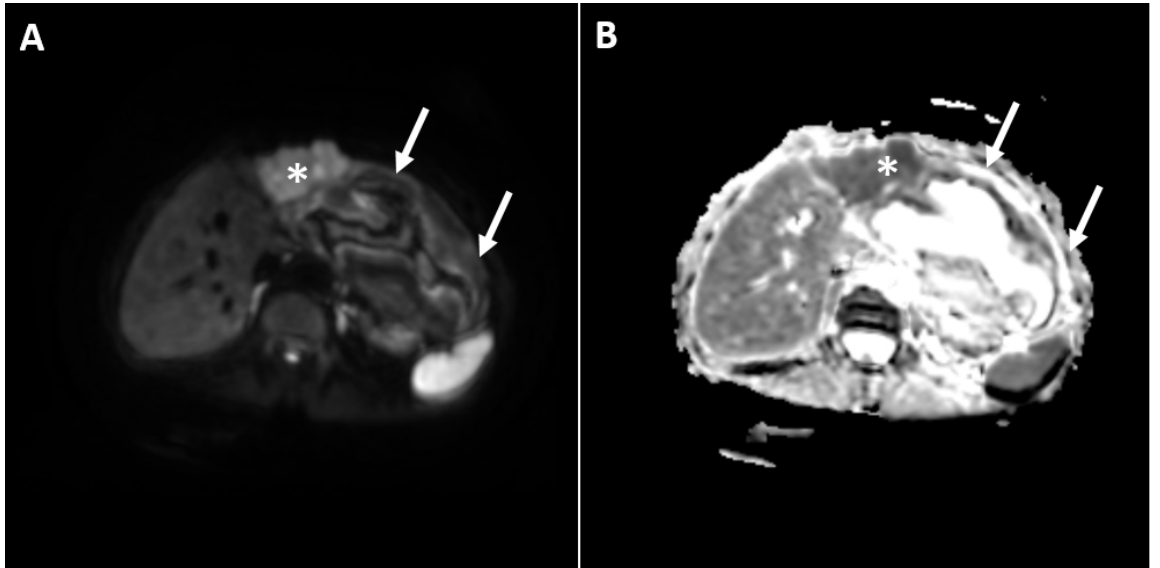
Figure 3. The diffusion weighted image ( A ) shows a solid tumor (asterisk) with a high signal intensity, indicating hypercellularity, and a cystic lesion next to the solid tumor (arrows) with a low signal intensity, suggesting acellularity. The corresponding ADC map is shown ( B ), with the ADC value of the solid tumor being 0.891 × 10 − 3 mm 2